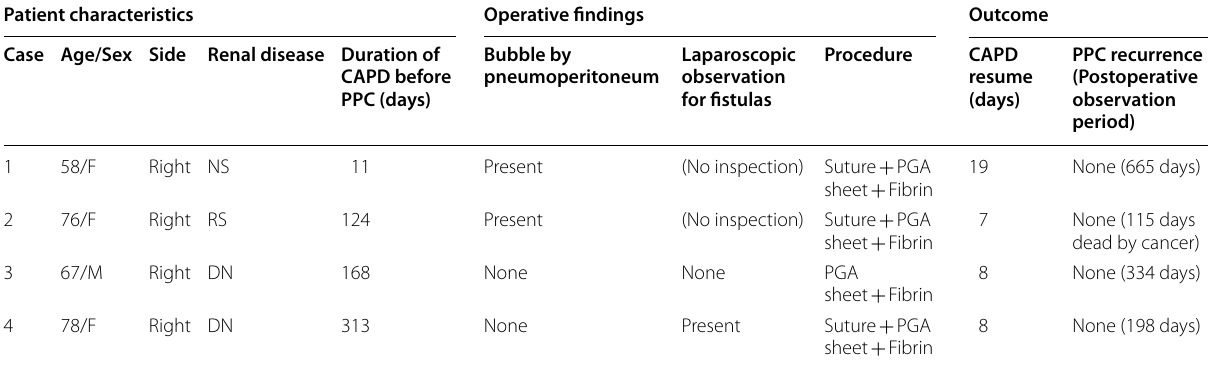
Table 1 Patient characteristics, operative findings, and